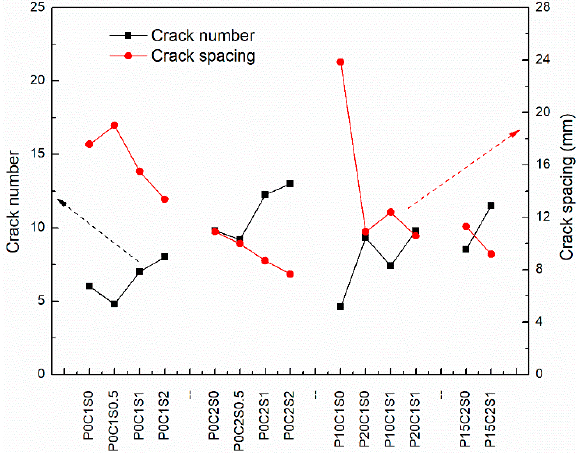
Figure 10. Crack number and spacing of TRM specimens.